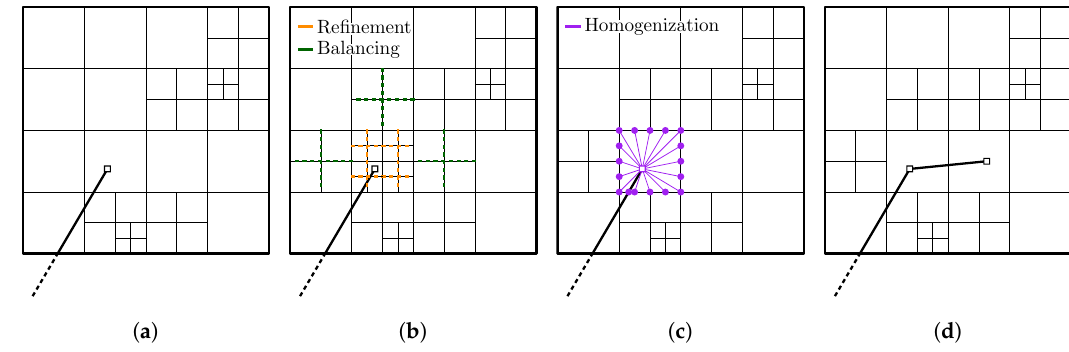
Figure 5. Main steps in SBFEM crack propagation scheme. ( a ) Crack entering existing balanced quadtree region.; ( b ) Refinement and balancing around crack tip; ( c ) Unifying cells into SBFEM macro element around crack tip; ( d ) New crack tip projected by gSIFs and ∆ a